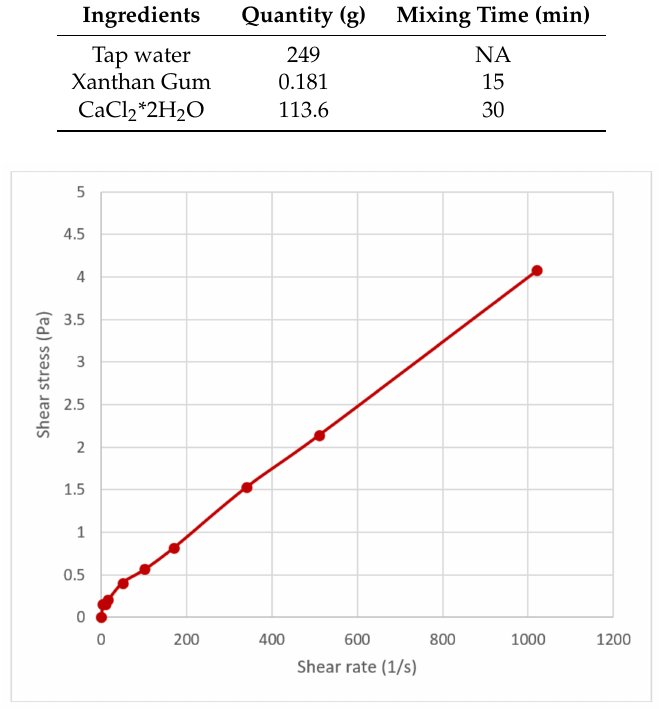
Figure 6. Flow curve of the viscosified